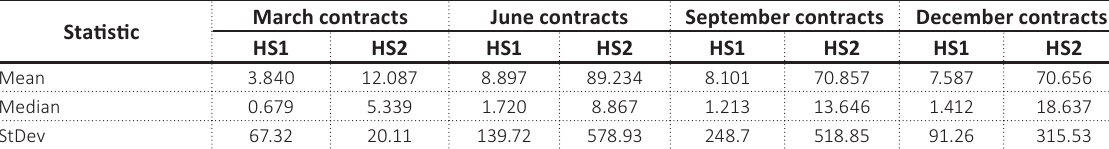
Table 4. Speculation-hedging demand measures